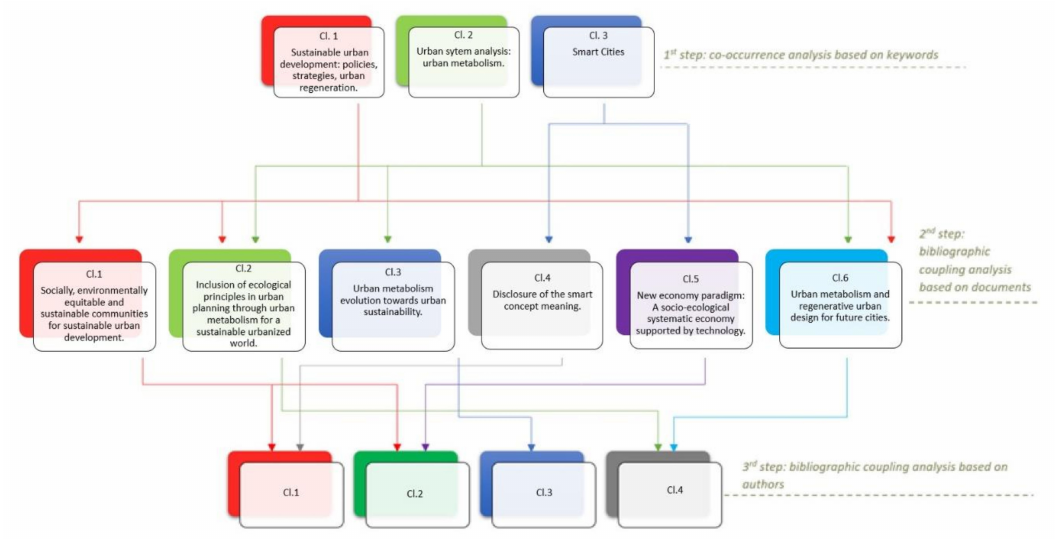
Figure 10. Map of cascade relations among the bibliometric